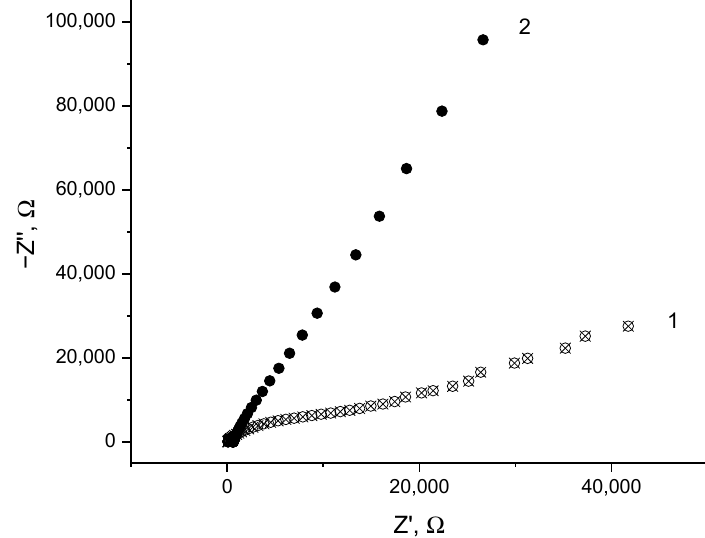
Figure 2. EIS spectra (Nyquist plot) of GC electrode, modified with Nafion™ (1) and with Co-g- C 3 N 4 —Nafion composite (2); reference electrode Ag|AgCl, sat KCl; electrolyte 0.1 M KCl with 5 mM Fe(CN) 63 − /4 − redox probe.